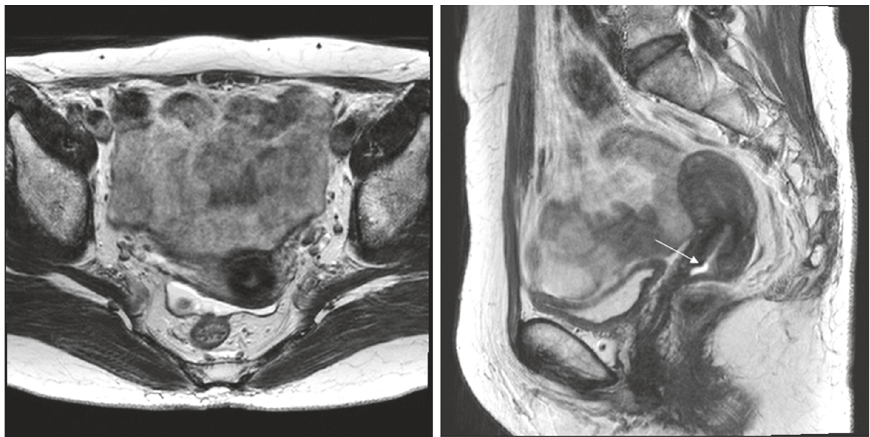
Figure 4: Stage IB1 squamous cervical carcinoma in a 58-year-old woman with radical hysterectomy (A) T2-weighted axial and (B) sagittal MR images show no gross cancerous lesion of uterine cervix but a tissue defect (arrow) after conization. At histopathological finding, no residual tumor in uterine cervix was found. MRI stage T0 was diagnosed as final pathologic stage T0b1.